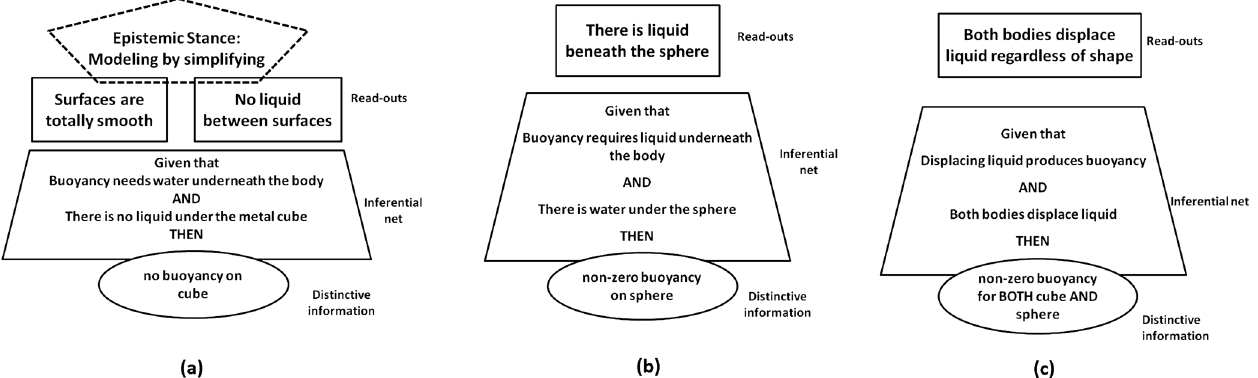
FIG. 3. Schematic diagrams of the three projections reported in S 1 . (a) No buoyancy on sunk cube, (b) nonzero buoyancy for sunk sphere, and (c) nonzero buoyancy for either sunk